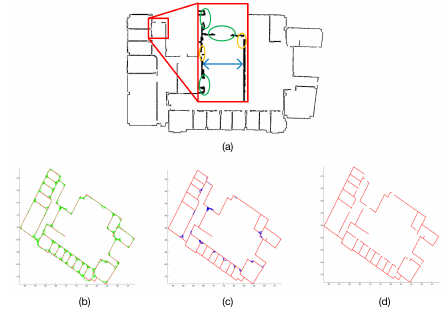
Figure 8. Top: the gaps in 2D point projection, the green circles represent the gap deriving from the real door while the gaps in the yellow circles resulting from occlusions. Bottom: three steps of door